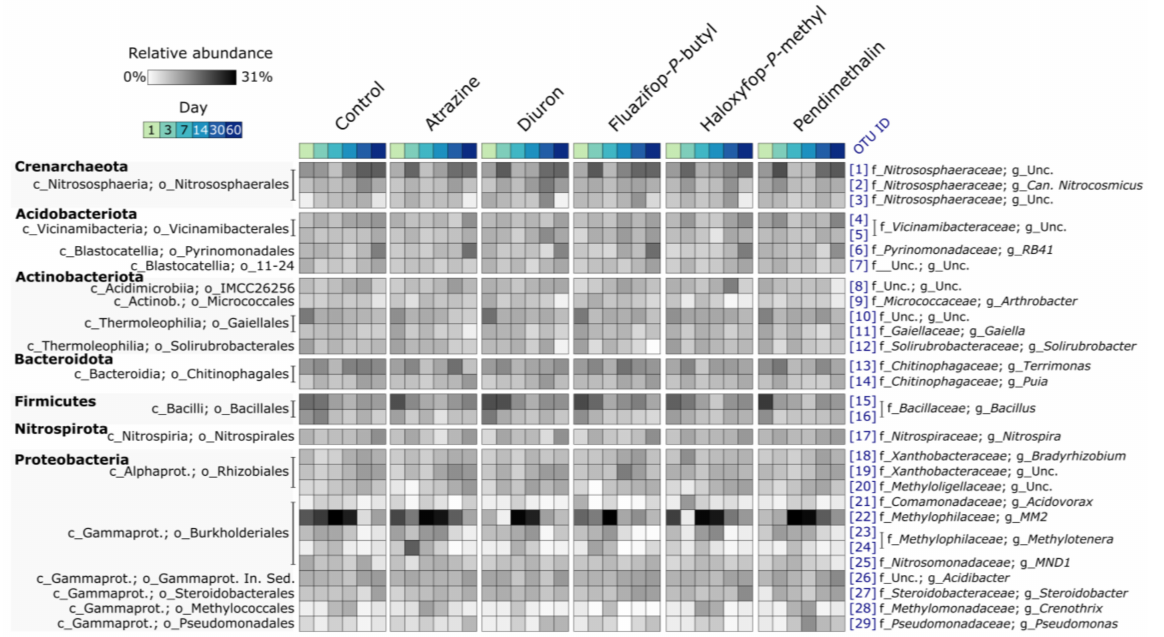
Figure 3. Heatmap summarising the relative abundances of bacterial and archaeal OTUs present at ≥ 1% mean relative abundance within any treatment group. Relative abundances are Hellinger transformed. The blue numbers in brackets are OTU IDs.